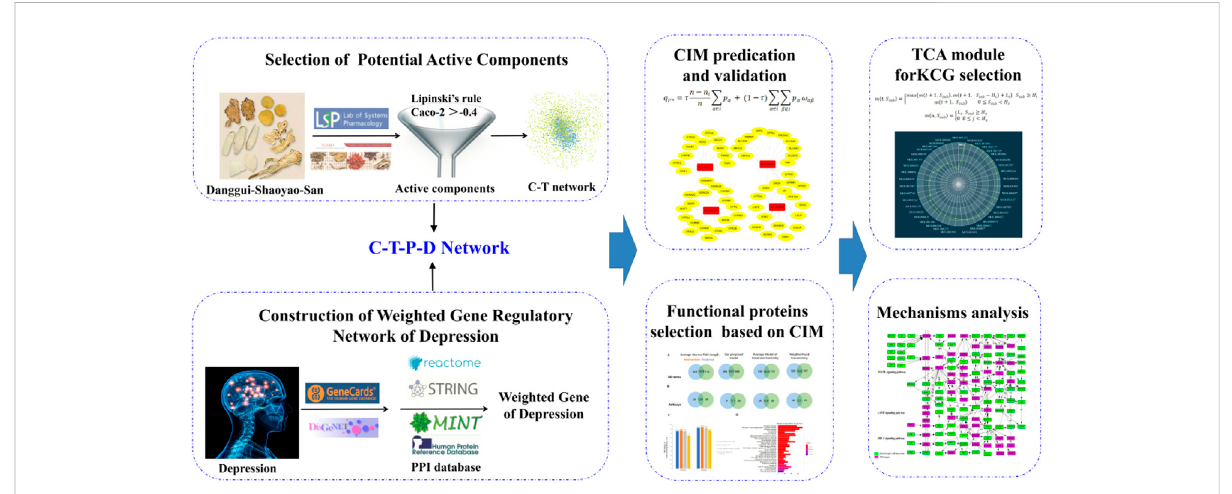
FIGURE 1 Flowchart of our proposed computational systems pharmacology